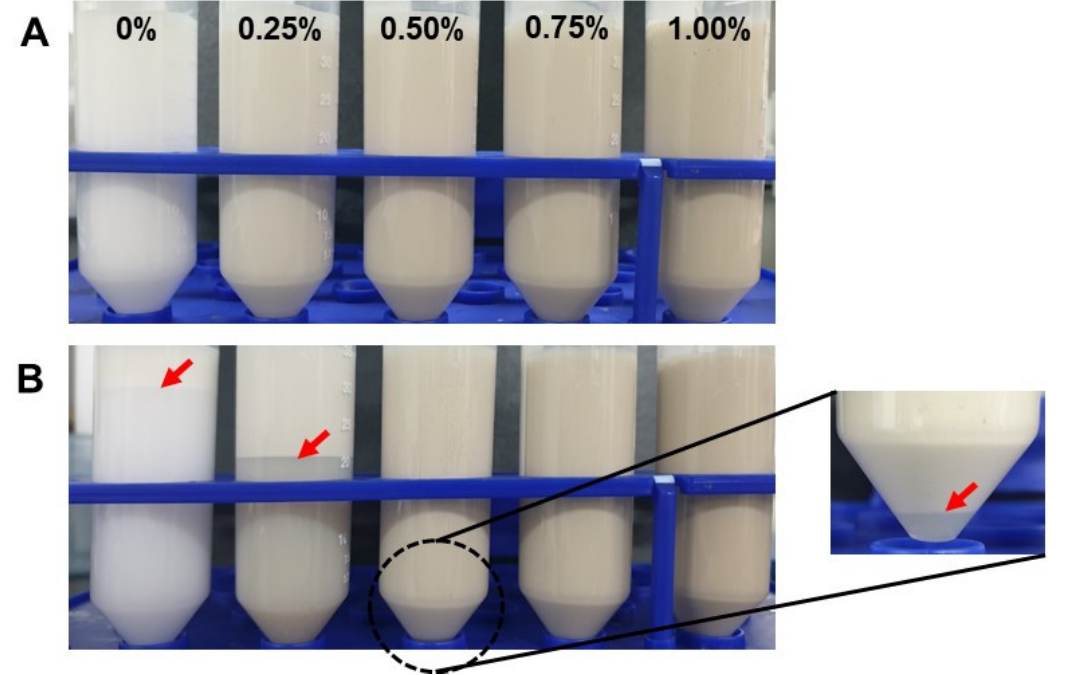
Figure 4. Visual observation of O/W emulsions containing different concentrations of C. olitorius mucilage: ( A ) fresh emulsion and ( B ) emulsions after seven days of storage. Table 1. Droplet size (nm) of O/W emulsions containing different concentrations of C. olitorius mu ‐ cilage during seven days of storage.